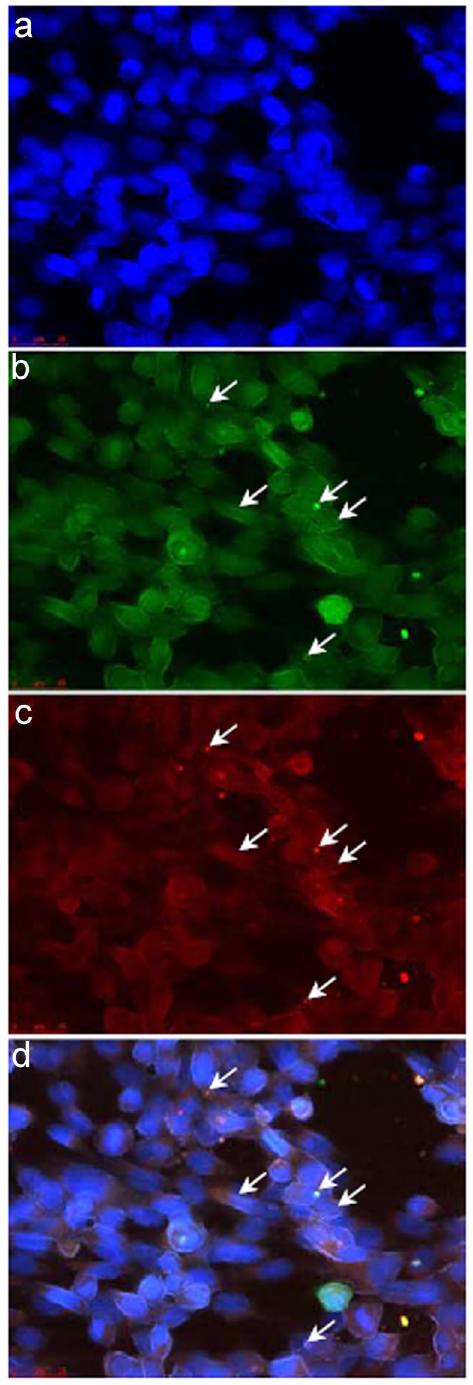
Figure 2. Testing the interaction between Mtk and SdhB in BHK-21 cells. The interaction between Mtk and SdhB was tested using the F2H assay 24 h after the transfection of BHK-21 cells. ( a ) DAPI channel. ( b ) GFP channel. ( c ) RFP channel. ( d ) Merged. The presence of both green and red spots (arrows) in the GFP and RFP channels, respectively, shows the interaction between Mtk and SdhB as confirmed by the presence of both green and red spots. Scale bars = 25 µ